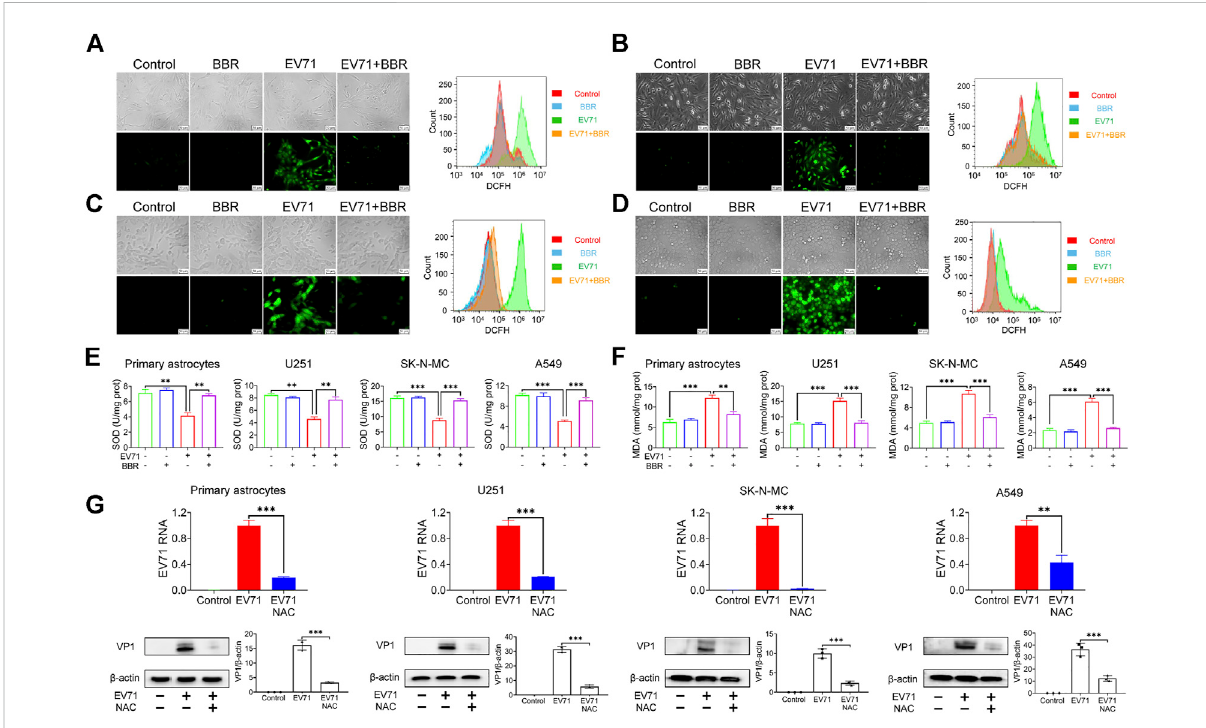
FIGURE 5 Effects of BBR on EV71-induced cellular ROS production. (A – D) ROS production in primary astrocytes, U251, SK-N-MC, and A549 cells with indicated maneuvers wasdetected using DCFH-DA by fl uorescence microscopy ( left )and FITC fl owcytometry( right ).Cells wereinfected with EV71 (MOI = 1) for 2 h, then treated with BBR (5 μ M for primary astrocytes and U251; 10 μ M for SK-N-MC and A549) for 24 h (E) and (F) Effects of BBR on SOD and MDA levels in cells infected for 24 h. (G) Effects of NAC on EV71 replication in the indicated cells. The cells were infected with EV71 (MOI = 1) for 2 h, and then treated with NAC (100 μ M) for 24 h. EV71 RNA was quanti fi ed by qPCR ( n = 6) and VP1 protein was detected by Western blot. Data are presented as SD. Statistical signi fi cance was compared between the test groups and the EV71 group was represented by